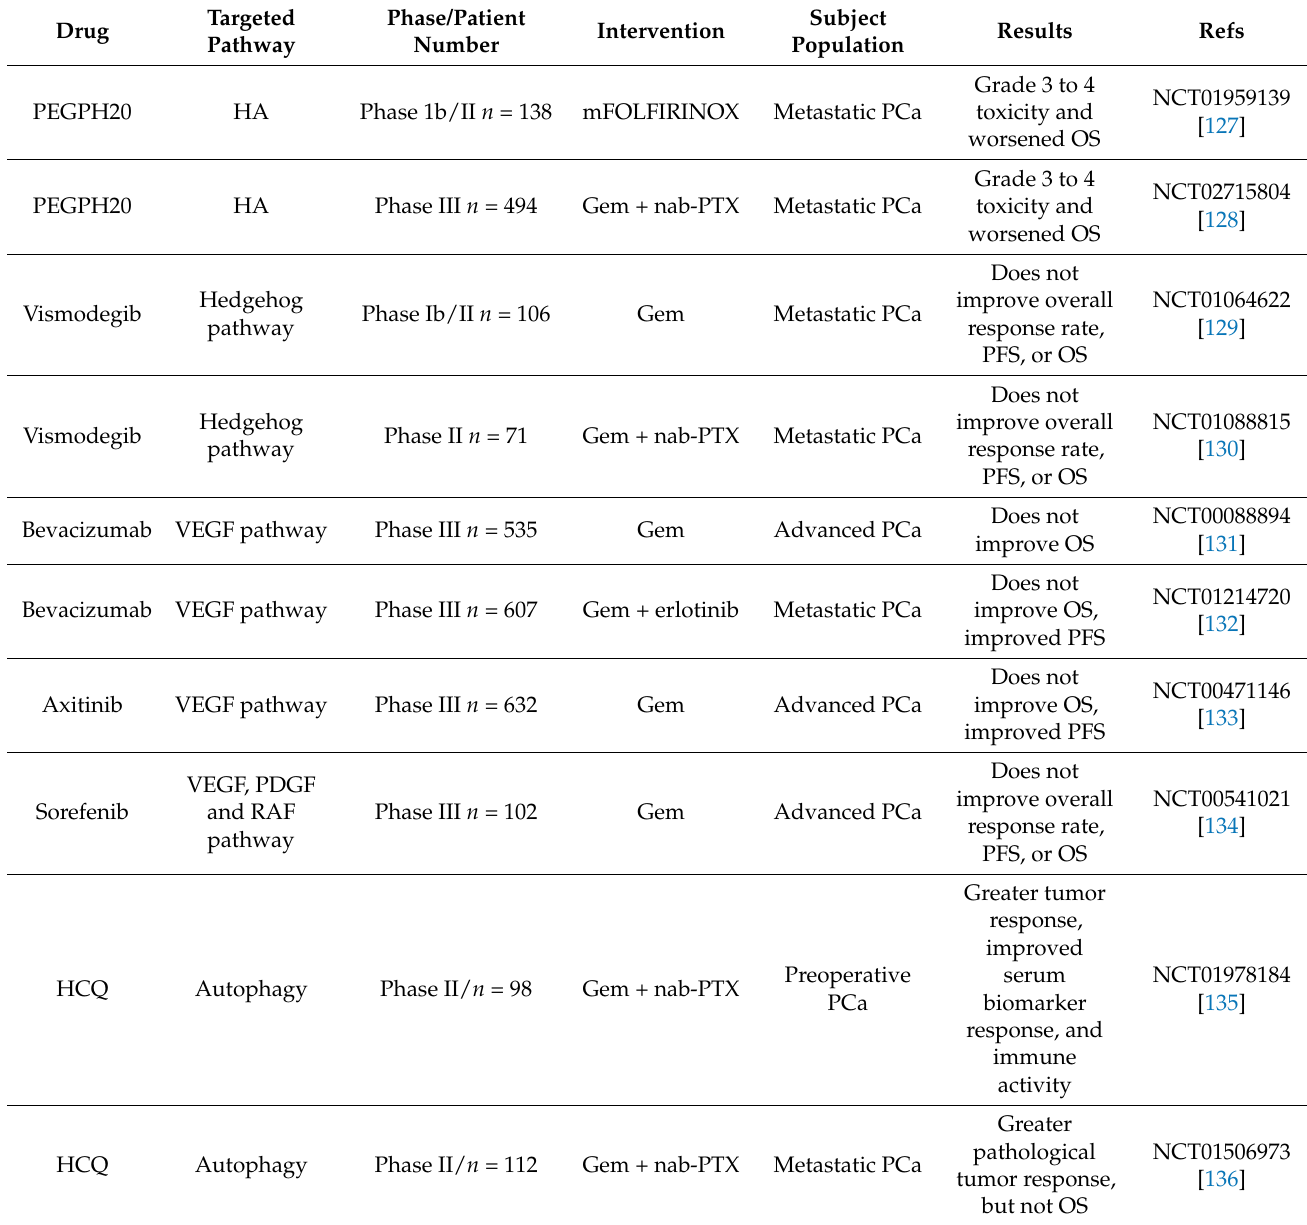
Table 1. Summary of clinical trials modulating the tumor microenvironment and metabolic reprogramming in PCa